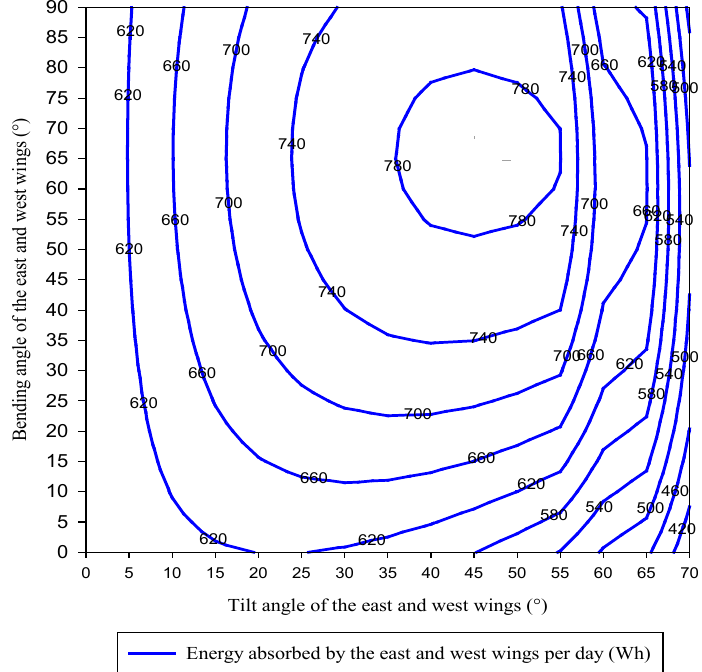
Figure 5. Sum of the energy absorbed by the east (until 11:00) and west (from 13:00) wings on 28 August 2005 at various tilt and bending angles.